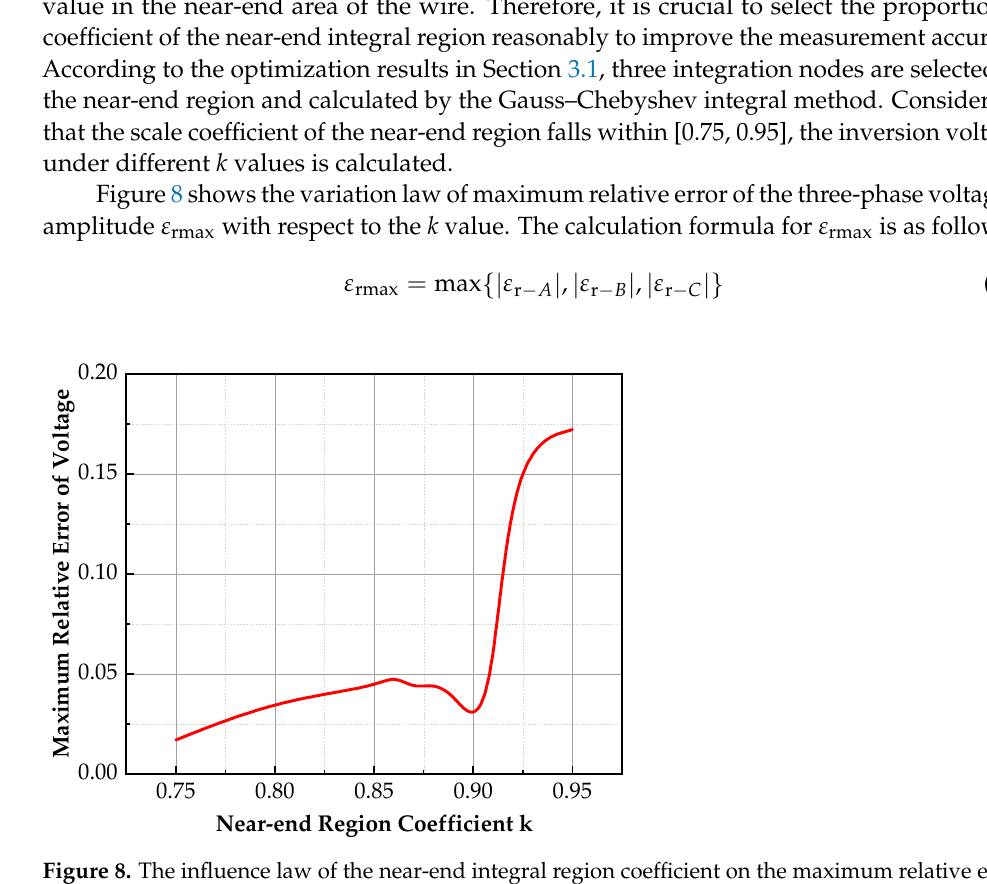
Figure 8. The influence law of the near-end integral region coefficient on the maximum relative error of the inversion voltage.